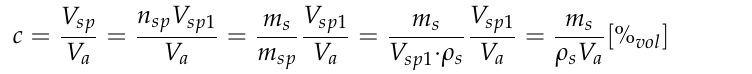
Figure 4. Dependence of probability and probability rate function on catalyst/precursor molar ra- tio.